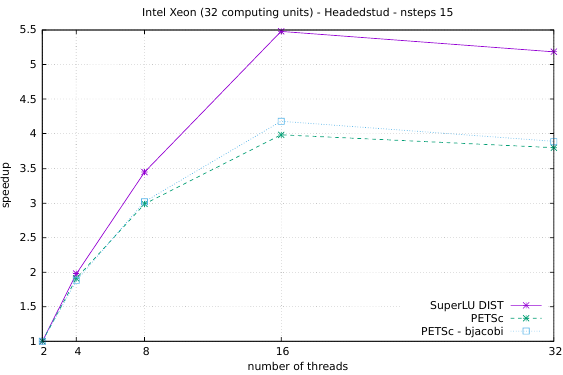
Figure 11. Speedups with using the Initial Stiffness Matrix